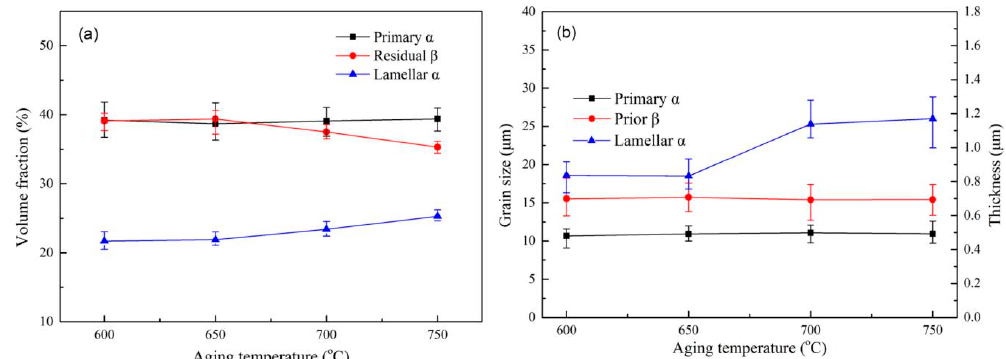
Figure 9. Microstructure under the different solution treatments followed by aging. ( a ) 960 °C × 1 h, AC + 600 °C × 2 h, AC; ( b ) 960 °C × 1 h, AC + 650 °C × 2 h, AC; ( c ) 960 °C × 1 h, AC + 700 °C × 2 h, AC; and ( d ) 960 °C × 1 h, AC + 750 °C × 2 h, AC.